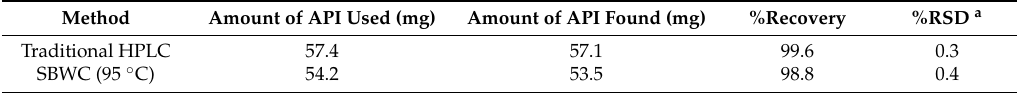
a Based on three replicate